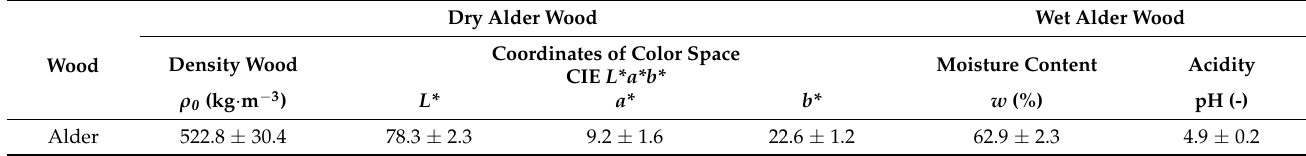
Table 2. Measured values of density, coordinates color space CIE L*a*b* of dry wood, moisture and acidity of wet wood: Alder. Dry Alder Wood Wet Alder Wood Density Wood Wood